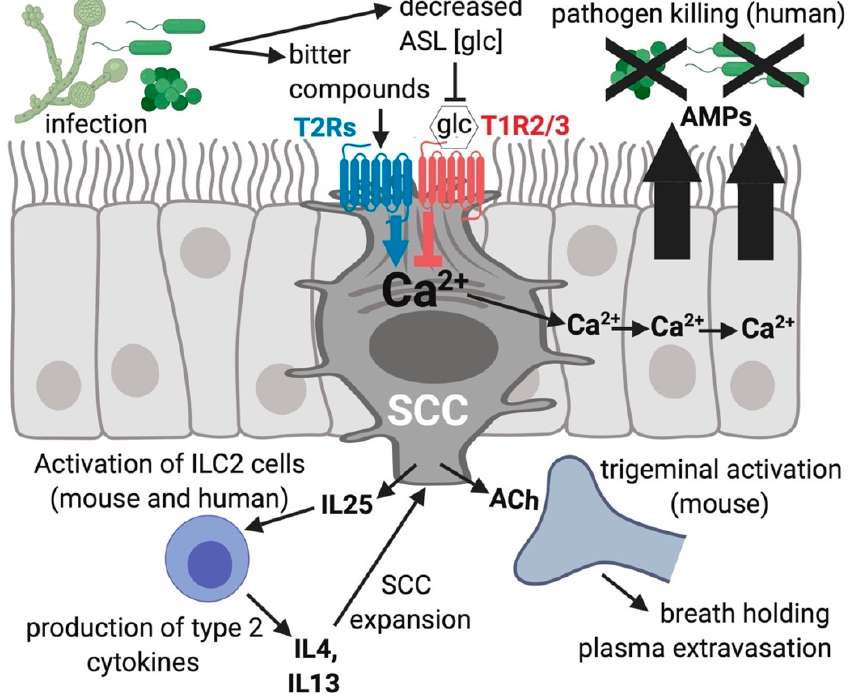
Figure 3. Solitary chemosensory cells (SCCs) function in innate immunity of the airway. Bitter compounds produced during infection can bind to and function as agonists of T2R bitter receptors in SCCs, resulting in a calcium (Ca 2+ ) response that travels via gap junctions to connecting ciliated and goblet cells via gap junctions [22]. The calcium propagation causes nearby cells to quickly ( ≤ 5 min) secrete stored antimicrobial proteins and peptides (AMPs). One type of AMPs are β -defensins, which directly kill fungi as well as gram-negative and gram-positive bacterial pathogens. During times of more sustained exposure to pathogens, SCCs produce cytokines and chemokines that activate inflammatory pathways which likely recruit specific types of immune cells. Stimulated SCCs can activate trigeminal afferent nerves through acetylcholine (ACh) causing plasma extravasation [23] and reflexive breath holding [25]. Airway surface liquid (ASL) glucose (glc) binds SCC T1R2/3 and reduces the activation of the T2Rs within the same SCC, leading to a decrease in AMP release [22,95]. The different isoforms of T2Rs in SCCs (isoforms 10, 46, 47) and cilia (isoforms 4, 14, 16, 38) respond to different subsets of compounds, potentially allowing the activation of the two different responses at distinct times, which likely depends on which specific infecting organisms and bitter metabolites are present in the airway.